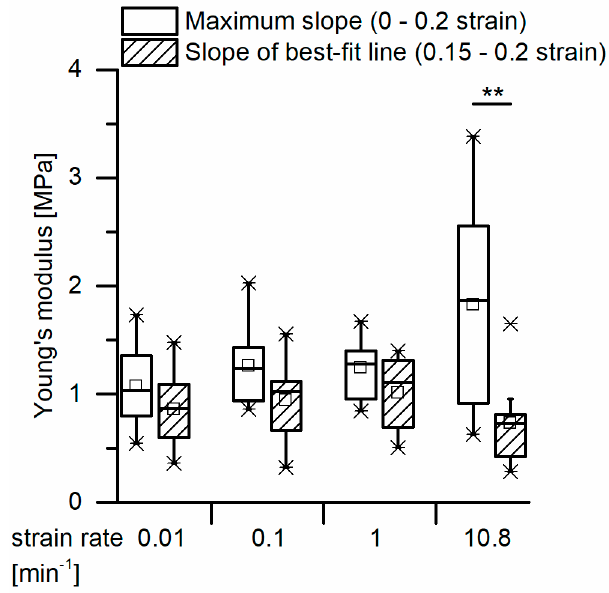
Figure 8. Comparison of the quasistatic compressive structural Young’s moduli derived by the two different approaches, at several strain rates. In one approach, the Young’s modulus is calculated as the maximum slope of the stress–strain curve until 20% strain. In a second approach, it is calculated as the slope of the best-fit line between 15% and 20% strain (statistical tests: Kruskal–Wallis test to compare the first mentioned method, ANOVA to compare the second mentioned method, Mann–Whitney U-tests to test the pairs for each strain rate; n = 10 for each group). Significant differences are marked by asterisks, with the levels of significance indicated as follows: ** p < 0.01.